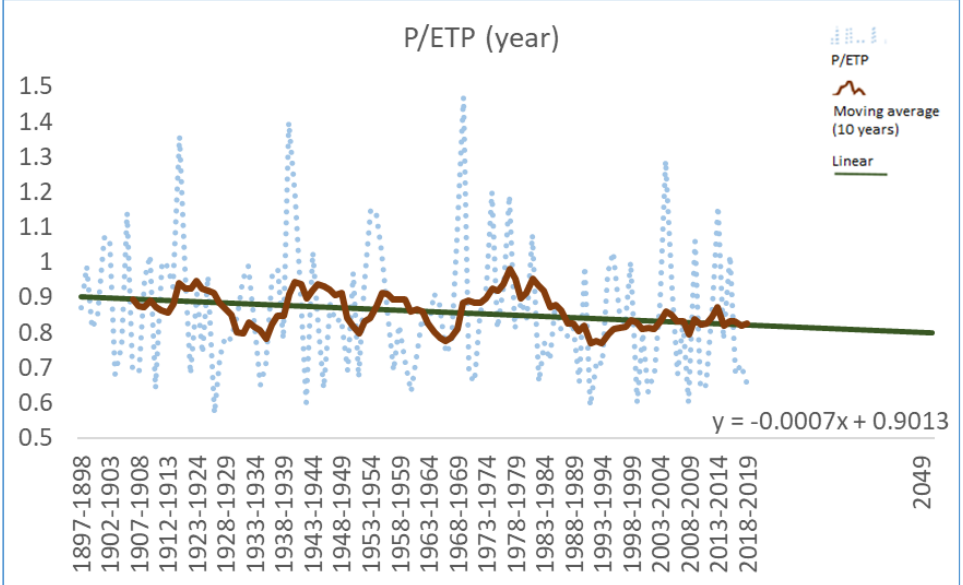
Figure 19. Evolution of the ratio of precipitation values accumulated during the year, with evapotranspiration, registered annually in Timișoara, Romania (P/ETP year), 1898-2019.